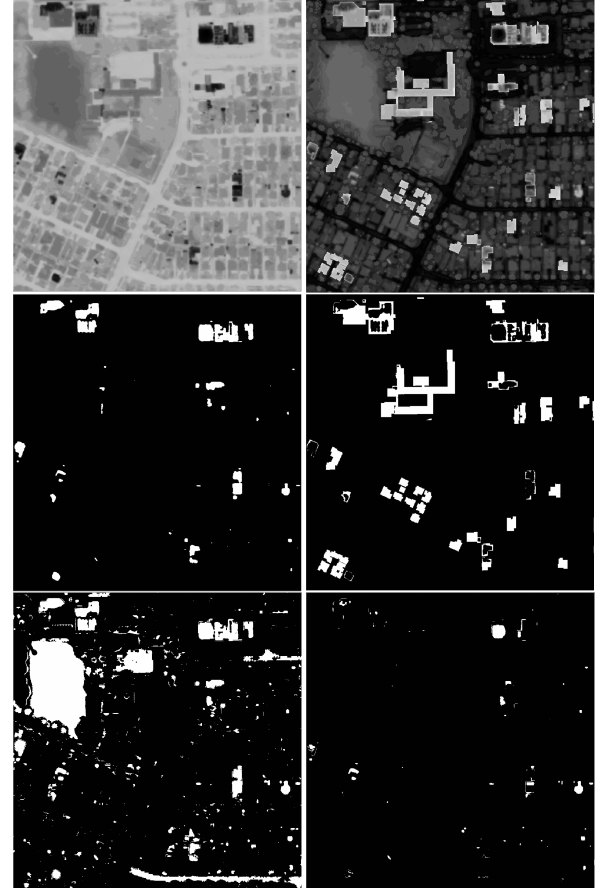
Figure 7. Detail of area 2. Top row: measured LWIR image (left) and difference image of measured and simulated LWIR image (right). Middle row: RXR results on measured LWIR image (left) and CDR result on difference image (right). Bottom row: RXRc result on measured LWIR image (left) and CDRc result on difference image (right).